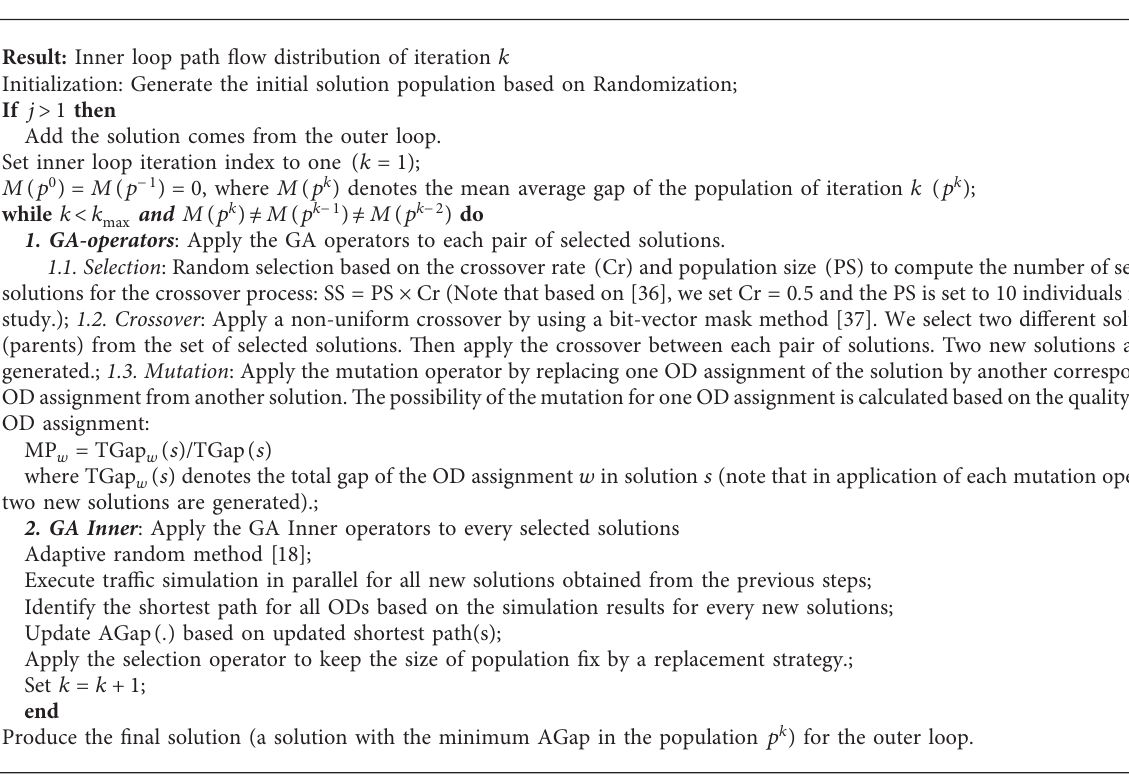
A LGORITHM 3: Genetic